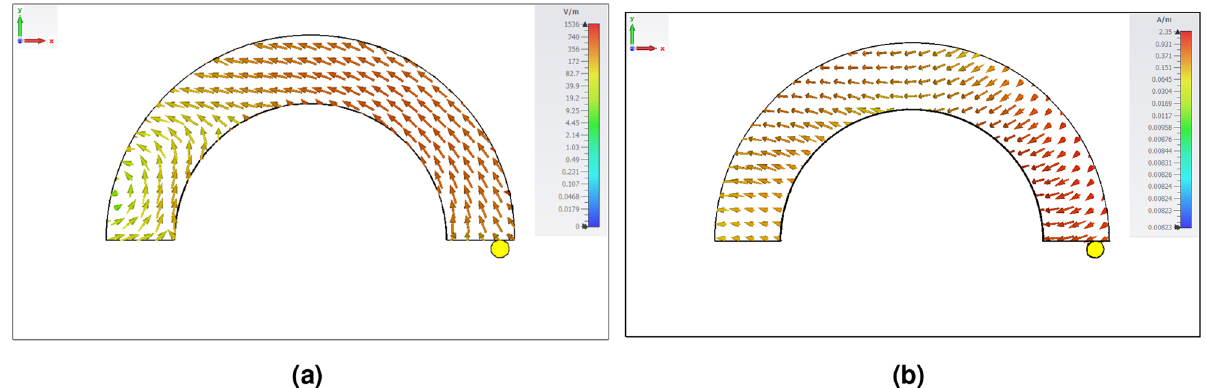
Figure 2. Modes of the AAS- DRA. ( a ) E-field of TE z 111 mode and ( c ) H-field of TM z 111